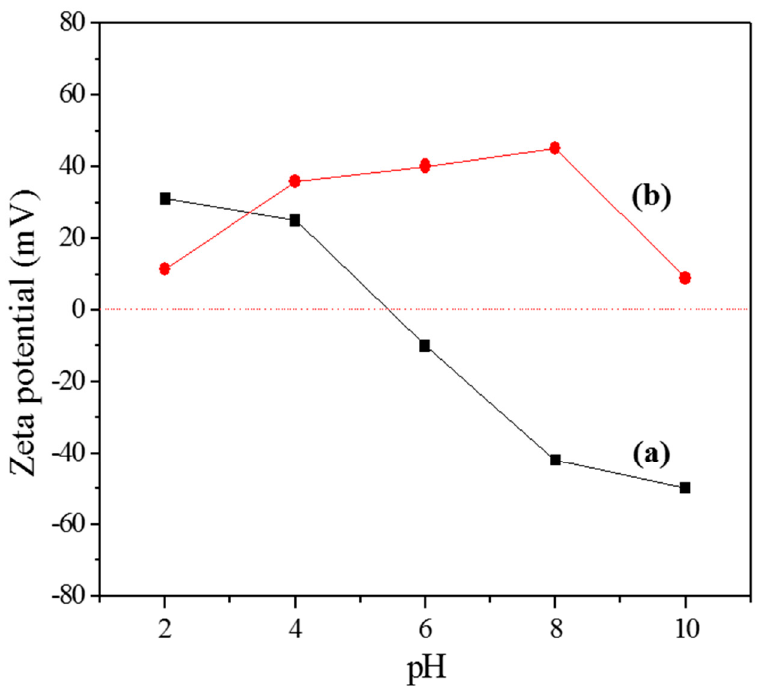
Figure 3. Zeta potential curves of ( a ) mica and ( b ) Y 2 O 3 :Eu 3+ as a function of pH.